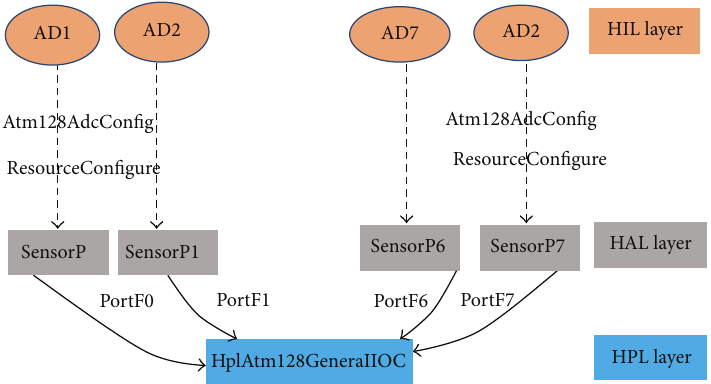
Figure 4: Pins driver program.